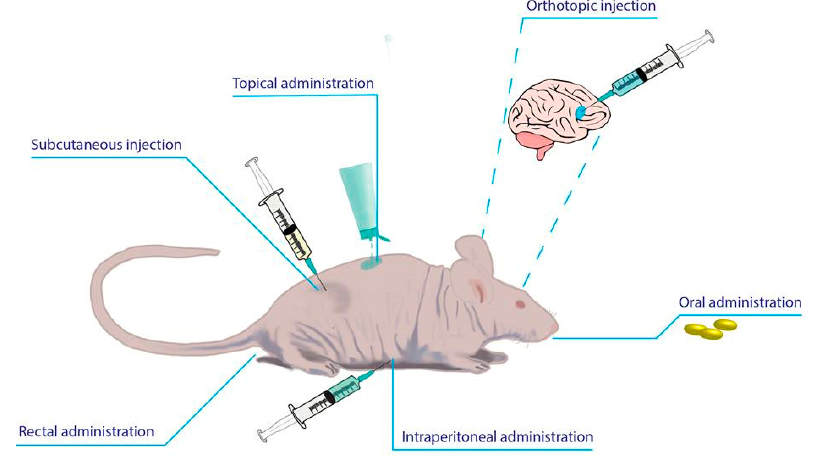
Figure 3. In vivo drug delivery hydrogel routes of administration. There are various methods for in vivo administration of hydrogel based products depending on the pathological conditions and their localization. Subcutaneous injection plays a crucial role in toxicological effects evaluation. Topical or transdermal application is preferred for skin associated problems. Orthotopic and intraperitoneal injections are non-invasive techniques which ensure good therapy results. On the other hand, oral administration has some limitations because of digestive